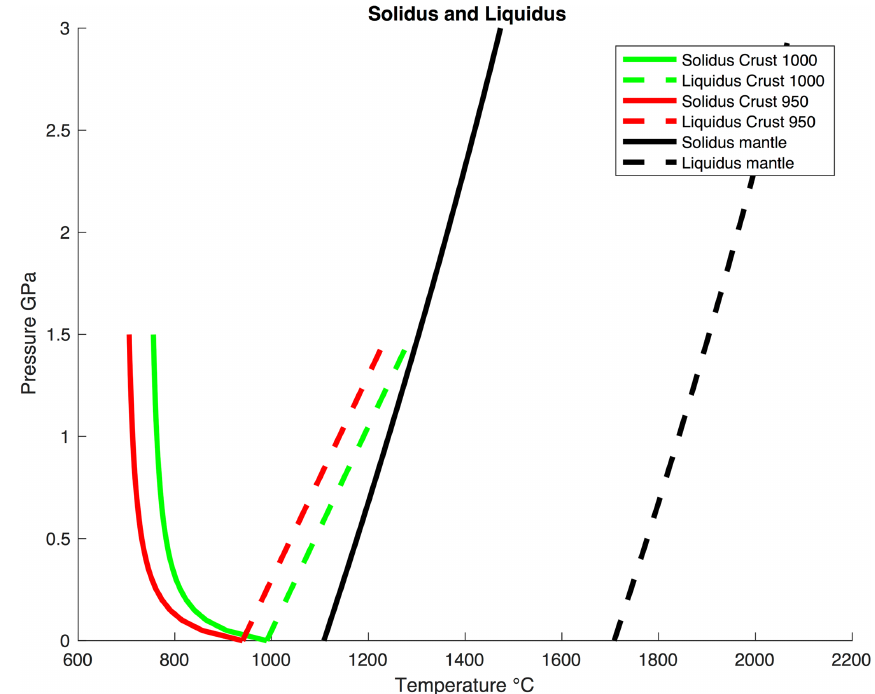
Figure A2. Solidus and liquidus as a function of pressure and temperature for mantle and crust (950 and 1000 ◦ C).